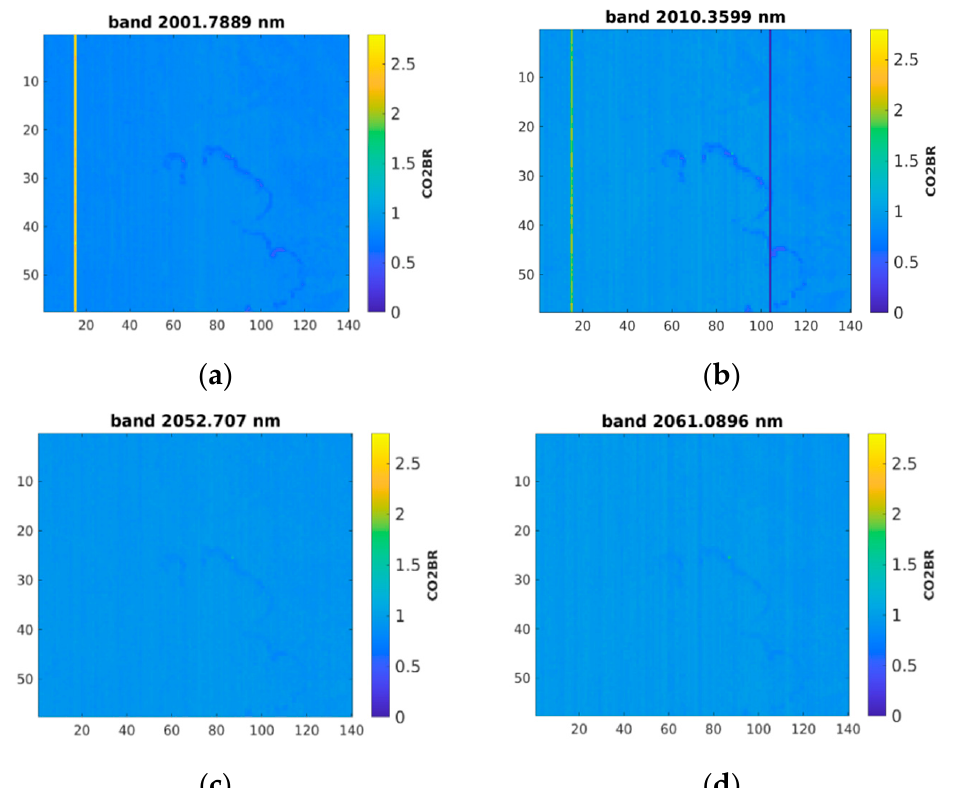
Figure 4. CO 2 -continuum interpolated band ratio (CIBR) maps. ( a ) CO 2 -CIBR derived for minimum absorption band centered at 2001.79 nm; ( b ) CO 2 -CIBR derived for minimum absorption band centered at 2010.36 nm; ( c ) CO 2 -CIBR derived for minimum absorption band centered at 2052.71 nm; ( d ) CO 2 -CIBR derived for minimum absorption band centered at 2061.09 nm. Table 3. CO 2 -CIBR detection